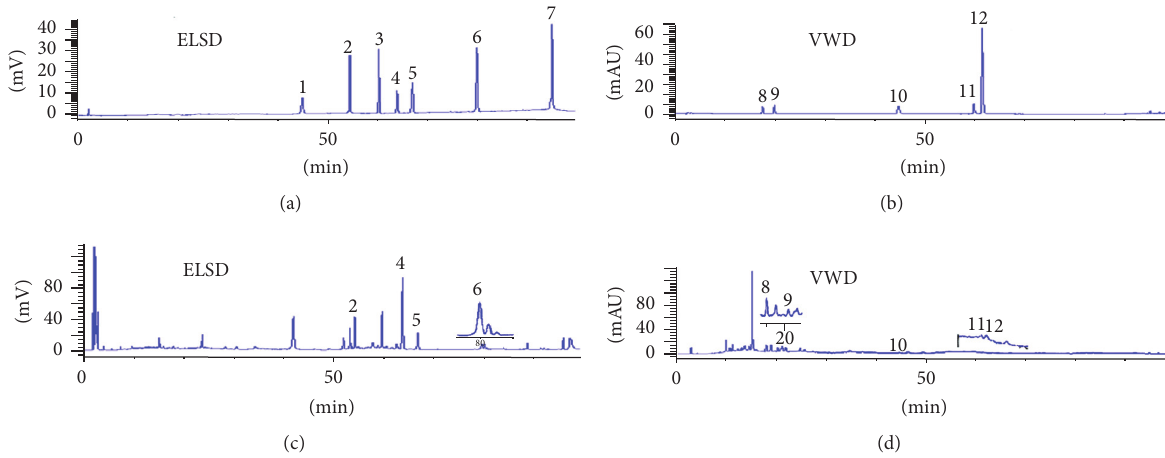
Figure 2: Typical HPLC-VWD-ELSD chromatograms for all of the reference compounds (a, b) and real sample (c, d). (1) Protodioscin, (2) (25R)-26-O- 𝛽 -D-glucopyranosyl-5 𝛼 -furostan-3 𝛽 ,22 𝛼 ,26-triol-3-O- 𝛽 -D-xylopyranosyl-(1 → 2)-[ 𝛽 -D-xylopyranosyl-(1 → 3)]- 𝛽 -D-glucopy- ranosyl-(1 → 4)-[ 𝛼 -L-rhamnopyranosyl-(1 → 2)]- 𝛽 -D-galactopyranoside, (3) Pseudoprotodioscin, (4) 26-O- 𝛽 -D-glucopyranosyl-(25R)-5 𝛼 - furostan-20(22)-en-3 𝛽 ,26-diol-3-O- {𝛽 -D-xylopyranosyl-(1 → 2)-[ 𝛽 -D-xylopyranosyl-(1 → 3)]- 𝛽 -D-glucopyranosyl-(1 → 4)-[ 𝛼 -L-rhamnopy- ranosyl-(1 → 2)]- 𝛽 -D-galactopyranoside } , (5) Terrestrinin A, (6) hecogenin-3-O- 𝛽 -D-glucopyranosyl(1 → 2)-[ 𝛽 -D-xylopyranosyl-(1 → 3)]- 𝛽 -D-glucopyranosyl-(1 → 4)- 𝛽 -D-galactopyranoside, (7) Tibllin, (8) Rutin, (9) Isoquercitrin, (10) kaempferol, (11) quercetin, and (12)